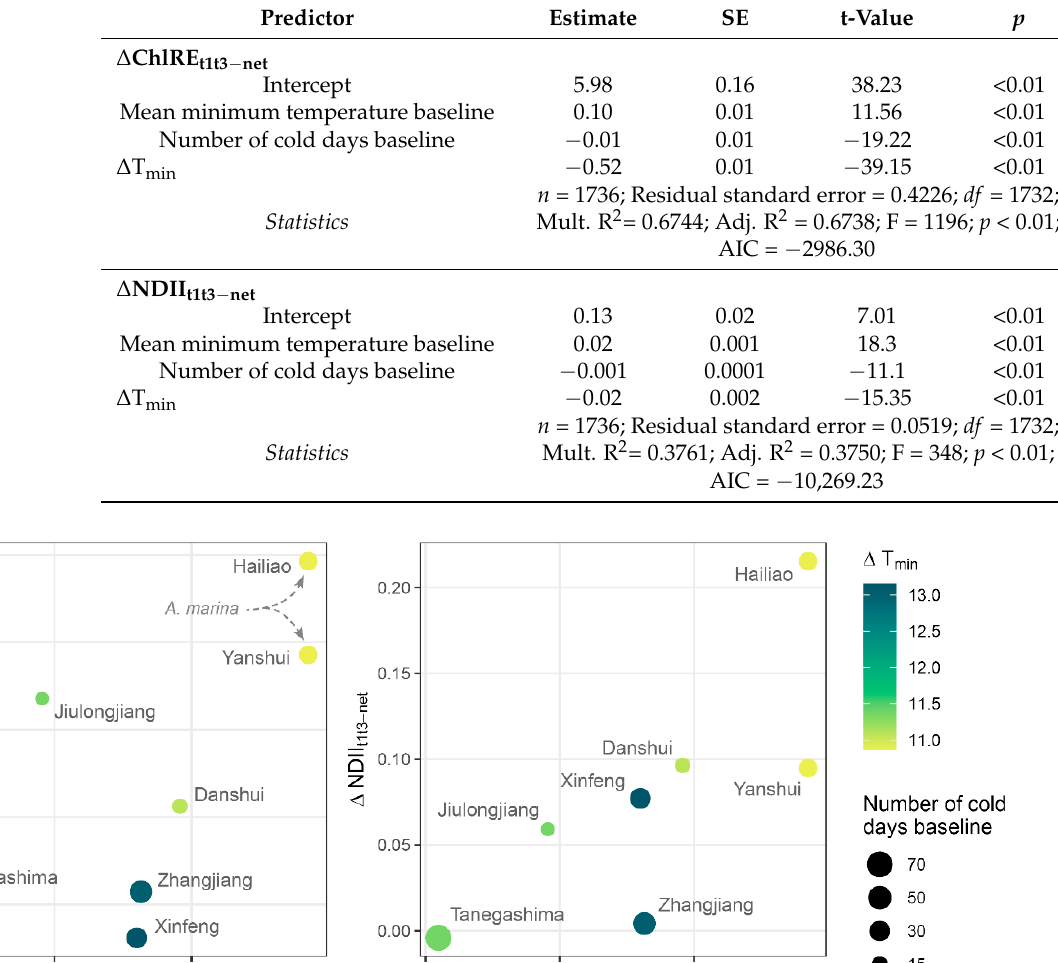
Table 6. Results of the stepwise model selection based on Akaike information criterion (AIC) for the net variation of chlorophyll red-edge index and normalized difference infrared index by t3 ( ∆ ChlRE t1t3 − net and ∆ NDII t1t3 − net ). Input predictors before model selection were: mean minimum temperature baseline, the amplitude in temperature in comparison with baseline ( ∆ T min ), and the number of cold days in the last five years using the same threshold.